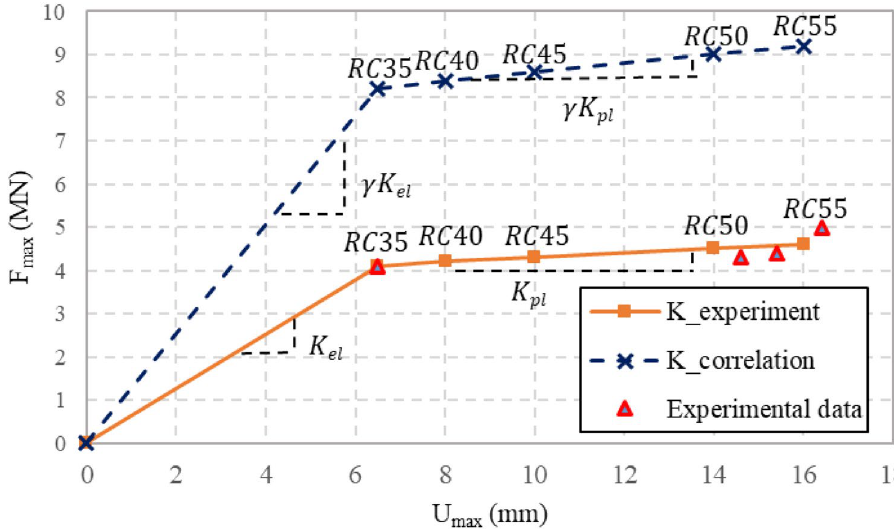
Figure 16. Measured elastic and plastic structural stiffness coefficient of the RC specimens.